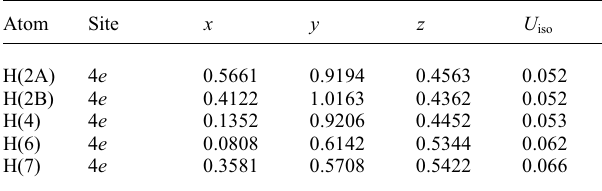
Table 3. Atomic coordinates and displacement parameters (in Å 2 )